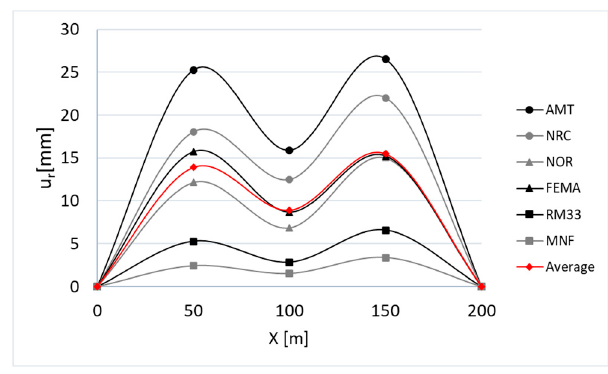
Figure 12. NRHA with scale factor 1.0—deck displacements.